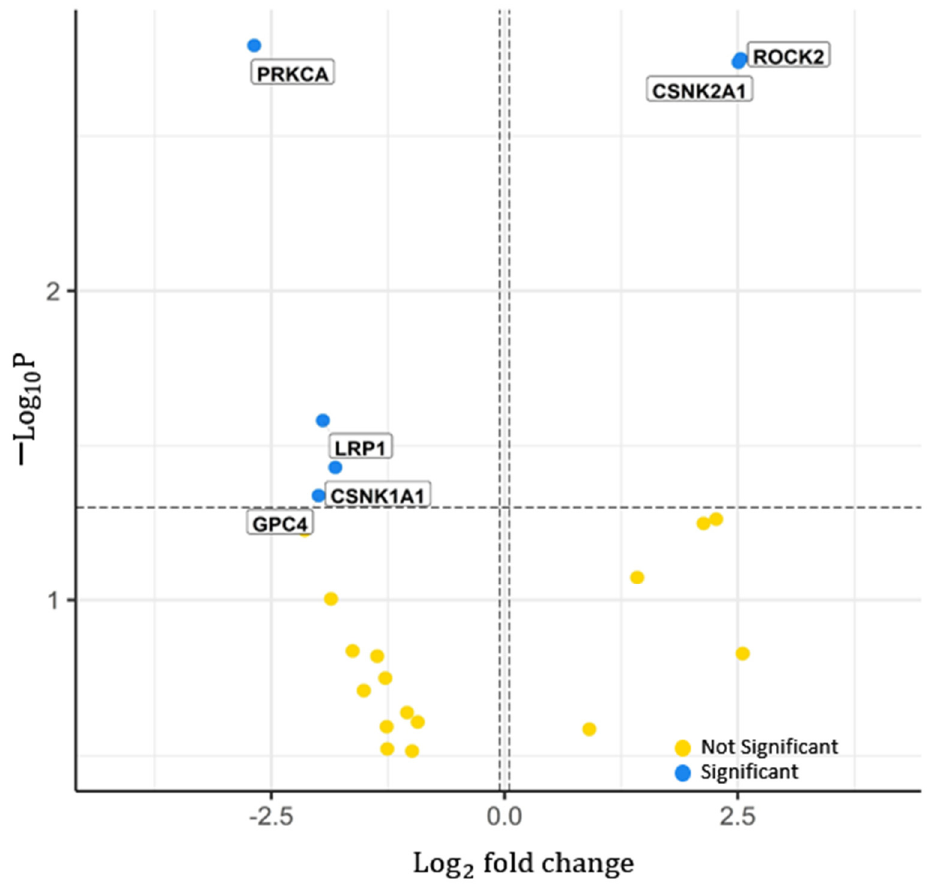
Figure 4. Significant proteins in the WNT signalling pathway. Distribution of the p -value (cid:4666)(cid:3398)log (cid:2869)(cid:2868) P) across the hazard ratio (log fold change) from the proteins analysed from proteomics TCGA legacy dataset. Features were divided into two; significant and not significant, represented by the blue and yellow dots, respectively. Labels represent the gene names of some significant features. p -value cut-off used = 0.05. Log fold change cut-off used = 1. Total number of features in WNT signalling pathway = 119. Total number of significant proteomics determined = 6.